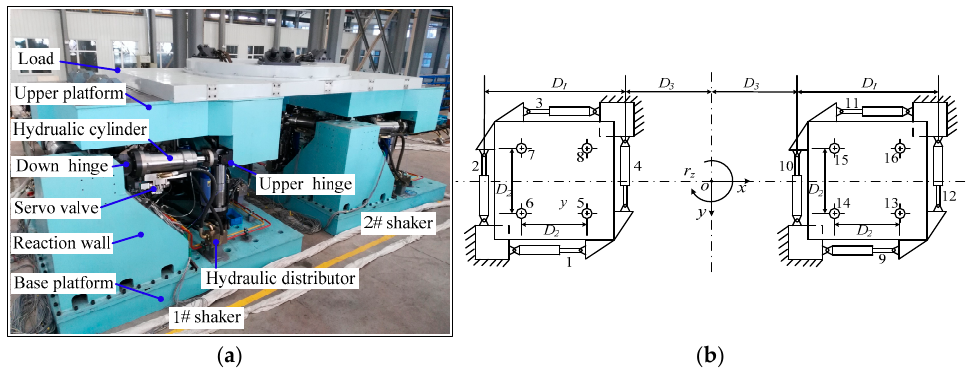
Figure 1. The electro ‐ hydraulic dual ‐ shaking table system. ( a ) Dual ‐ shaking table; ( b ) Top view of dual ‐ shaking table.